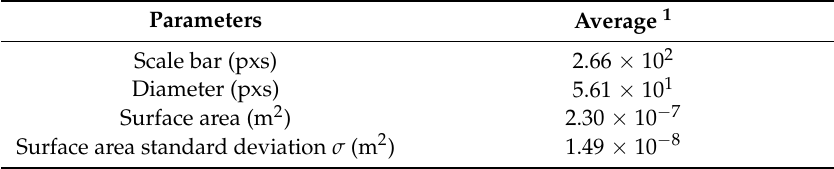
Table 3. Results for automatic image conversion to binary method.